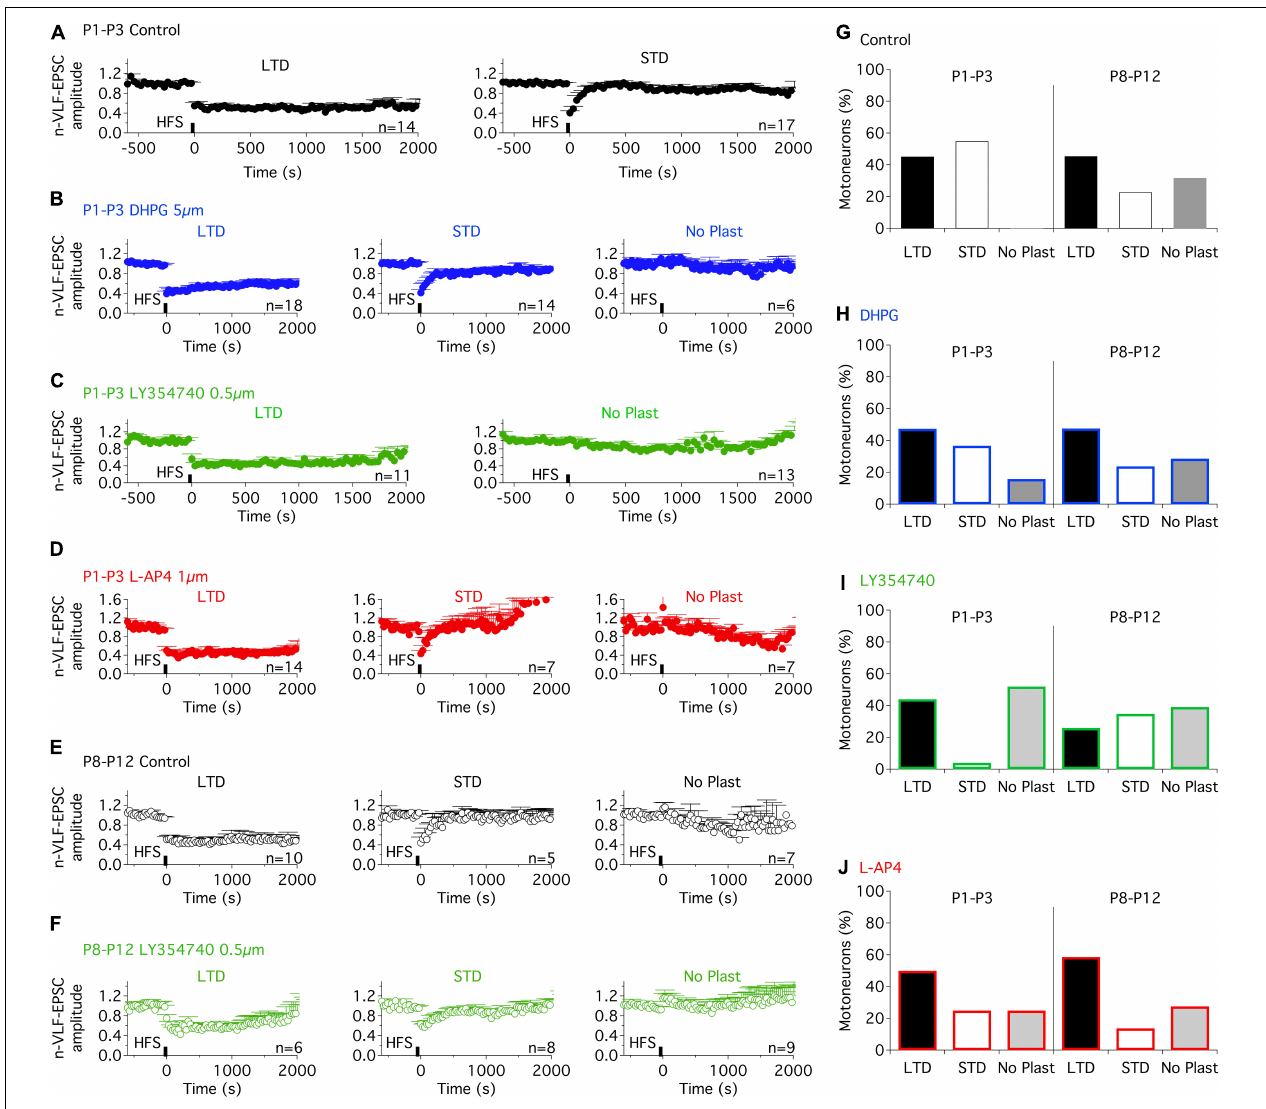
FIGURE 2 | Metabotropic glutamate receptor (mGluR) agonists differentially modulate the ADSP expressed at VLF-MN synapses during development. (A) Pooled data average time courses of VLF-HFS-induced LTD (left panel) or STD (right panel) in lumbar MNs of P1-P3 mice in control condition. (B) Same layout as in (A) (note, with addition of the time course in the absence of plasticity, right) in the presence of the mGluRI agonist, DHPG. (C) Plasticity time courses in the presence of the mGluRII agonist, LY354740 in P1-P3 MNs. Note the absence of STD in the presence of LY354740. (D) LTD, STD and No Plast were expressed in the presence of the mGluRIII agonist, L-AP4 in P1-P3 MNs. (E) Pooled data average time courses of VLF-HFS-induced LTD (left panel), STD (middle panel) or No Plasticity (right panel) in lumbar MNs of P8-P12 mice in control condition. (F) Same layout as in E in the presence of the mGluRII agonist, LY354740. (G–J) Percentages of MNs expressing each type of synaptic plasticity profile in control condition (G) , in the presence of DHPG (H) , LY354740 (I) and L-AP4 (J) for the two developmental stages tested. Note that the ADSP expression was similar in control condition and in the presence of the mGluR agonists in P8-P12 MNs. The distribution of the different ADSP profiles expressed in the presence of mGluR agonists was found significantly different in P1-P3 MNs but not in P8-P12 MNs in the presence of the mGluR agonists (Chi square test, p < 0.0001 and p = 0.44,